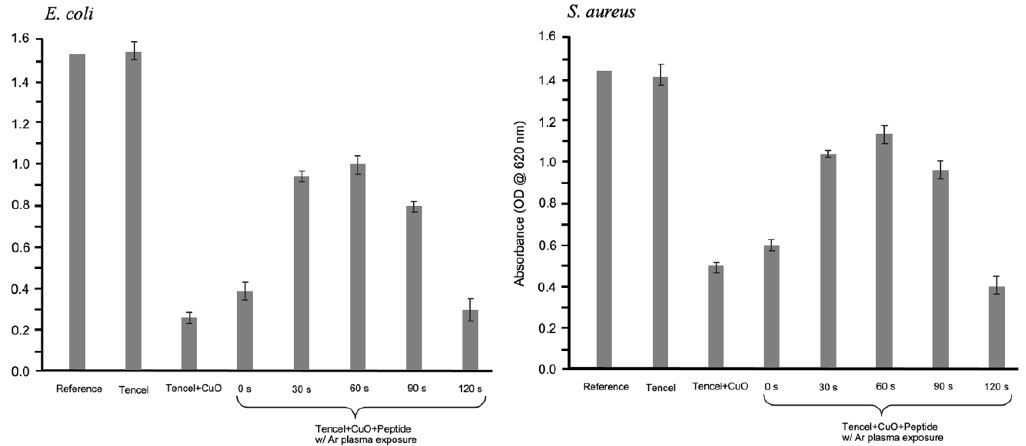
Figure 6. Absorbance, as measured at 620 nm, of E. coli ( left ) and S. aureus ( right ) bacterial broth exposed to various membranes.